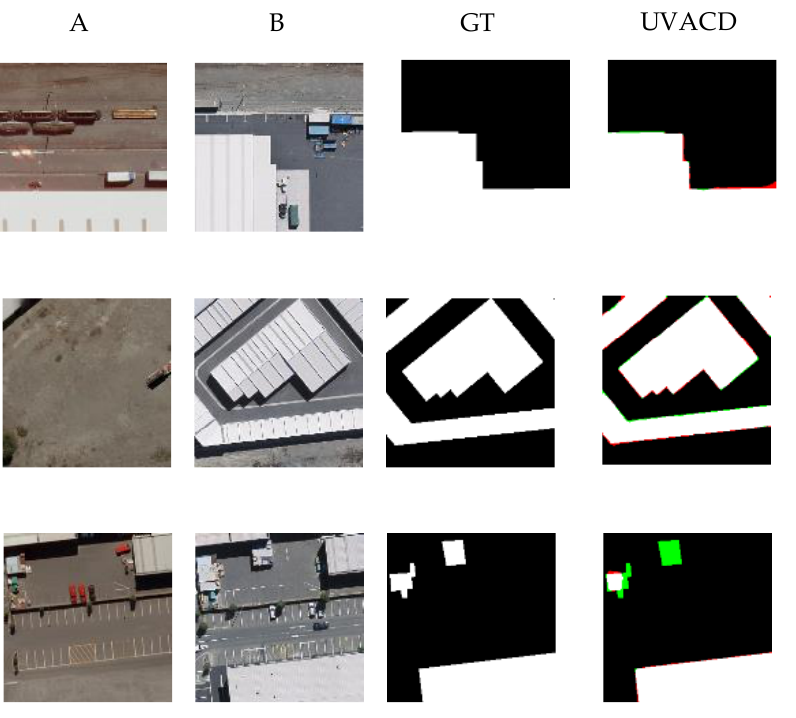
Figure 8. WHU-CD test image results. Table 3. The average quantitative results obtained by different CD methods on LEVIR-CD test set. (largest in red, second-largest in blue; all values are reported as percentages (%)). Methods F1 IoU Recall